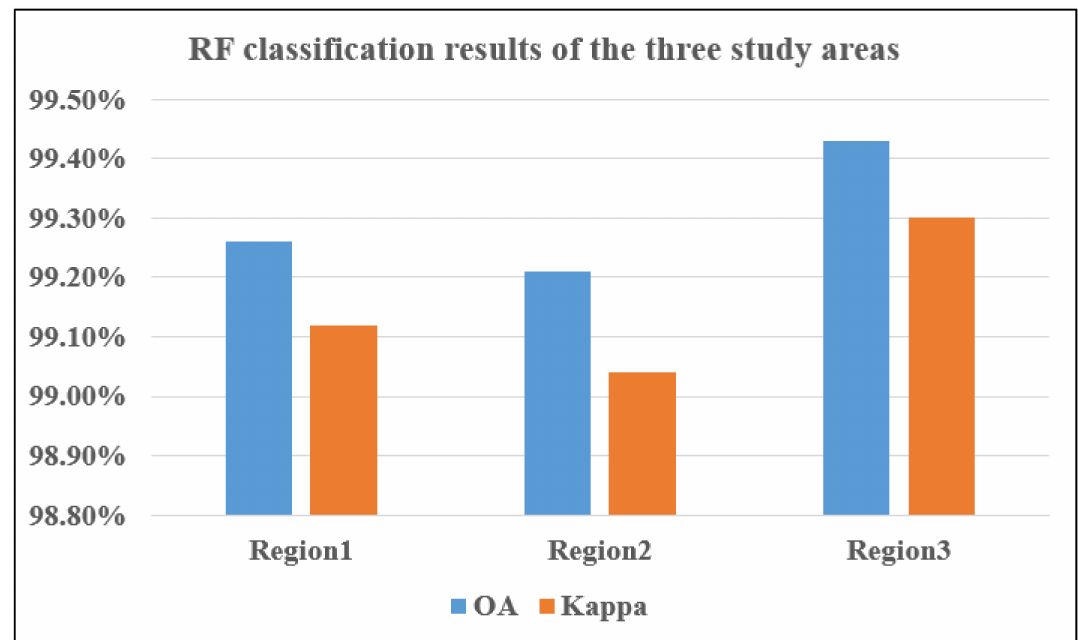
Figure 7. Overall accuracy and kappa of RF classification results in three study areas.